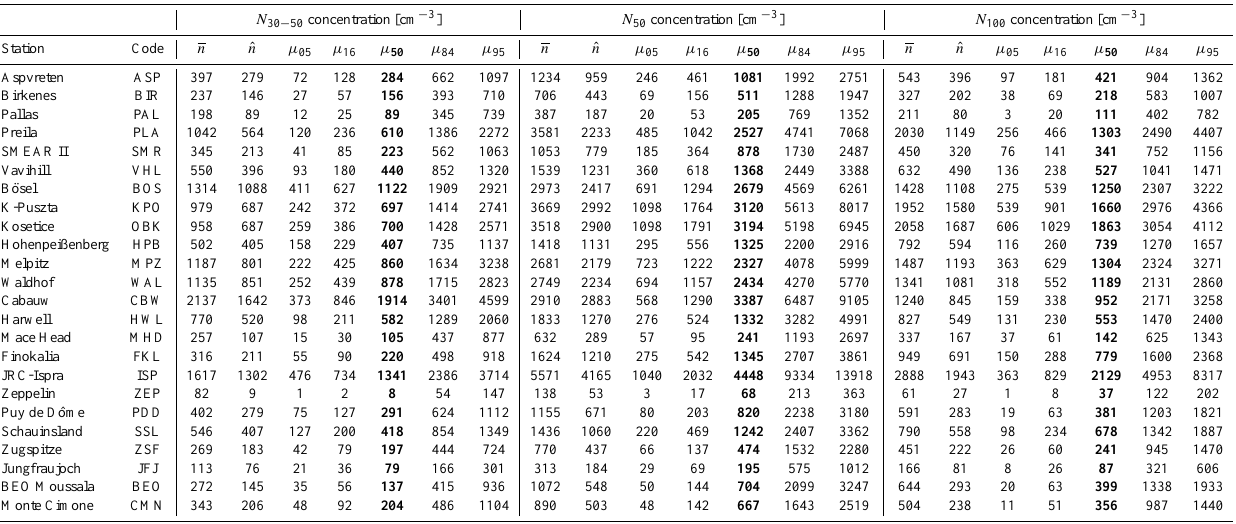
Table 4. Mean values of the station concentrations. n is the arithmetic mean concentration in the size section in question, ˆ n is the geometric mean concentration and the µ x values are the x-th percentage of the concentration distribution. µ 50 , or median value, is bolded. All concentrations are in [cm − 3 ] . Refer to Sect. 2.2.1 for details on instrumental